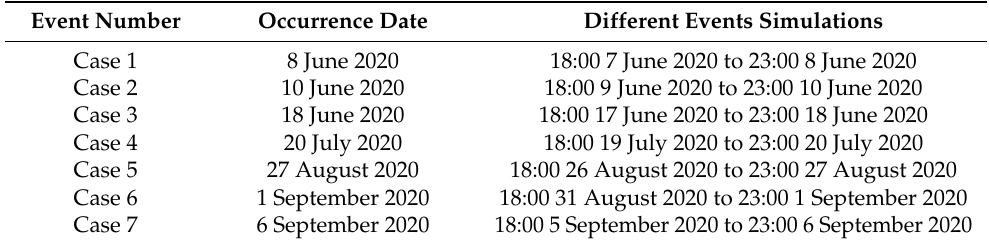
Table 1. List of significant weather events and simulation period during the summer of